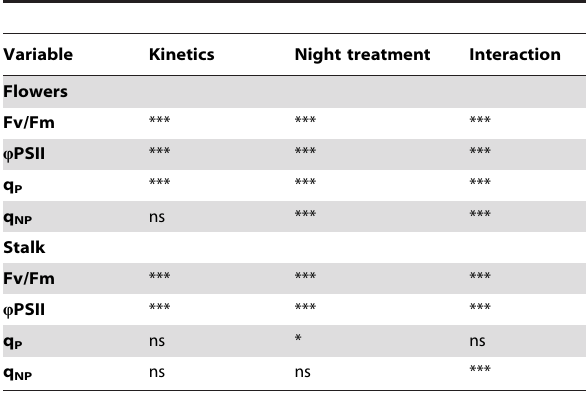
Table 3. Results of two-way ANOVA of the impact of night temperature on chlorophyll fluorescence